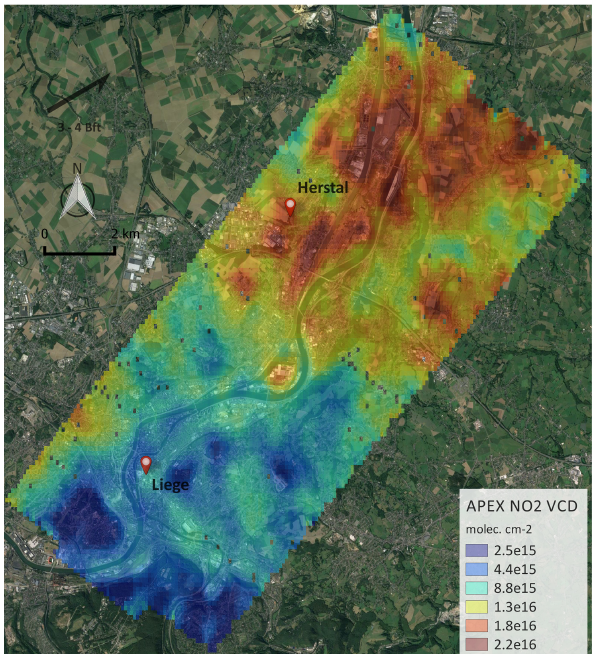
Figure 19. Retrieved NO 2 VCD field for Liège (15 April 2015) (Google, TerraMetrics).